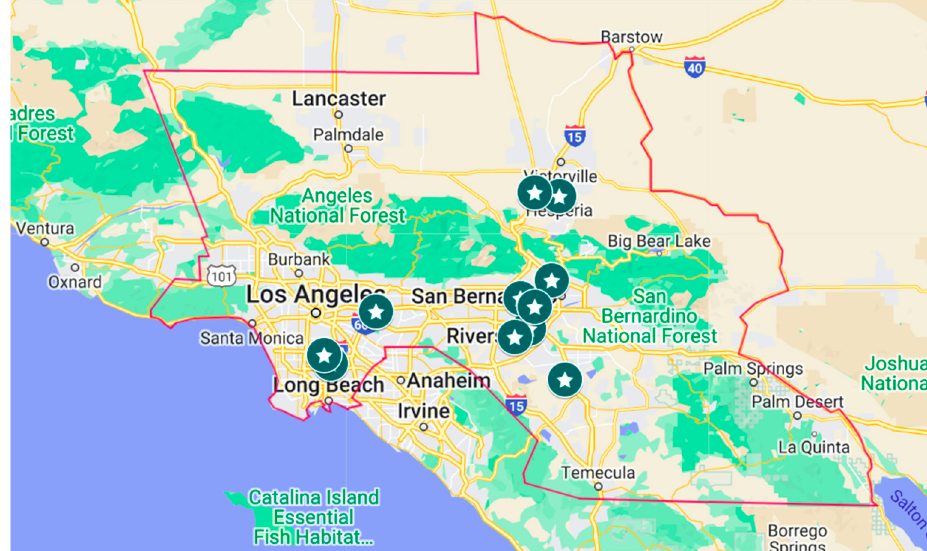
Figure 1. Feedstores visited ( ∗ ) for Newcastle vaccine distribution within the regional quarantine area (red line) that was established by the CDFA during the 2018–2020 vND outbreak in Southern California.